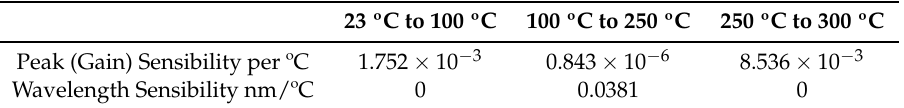
Table 1. Sensibility values for the peak.